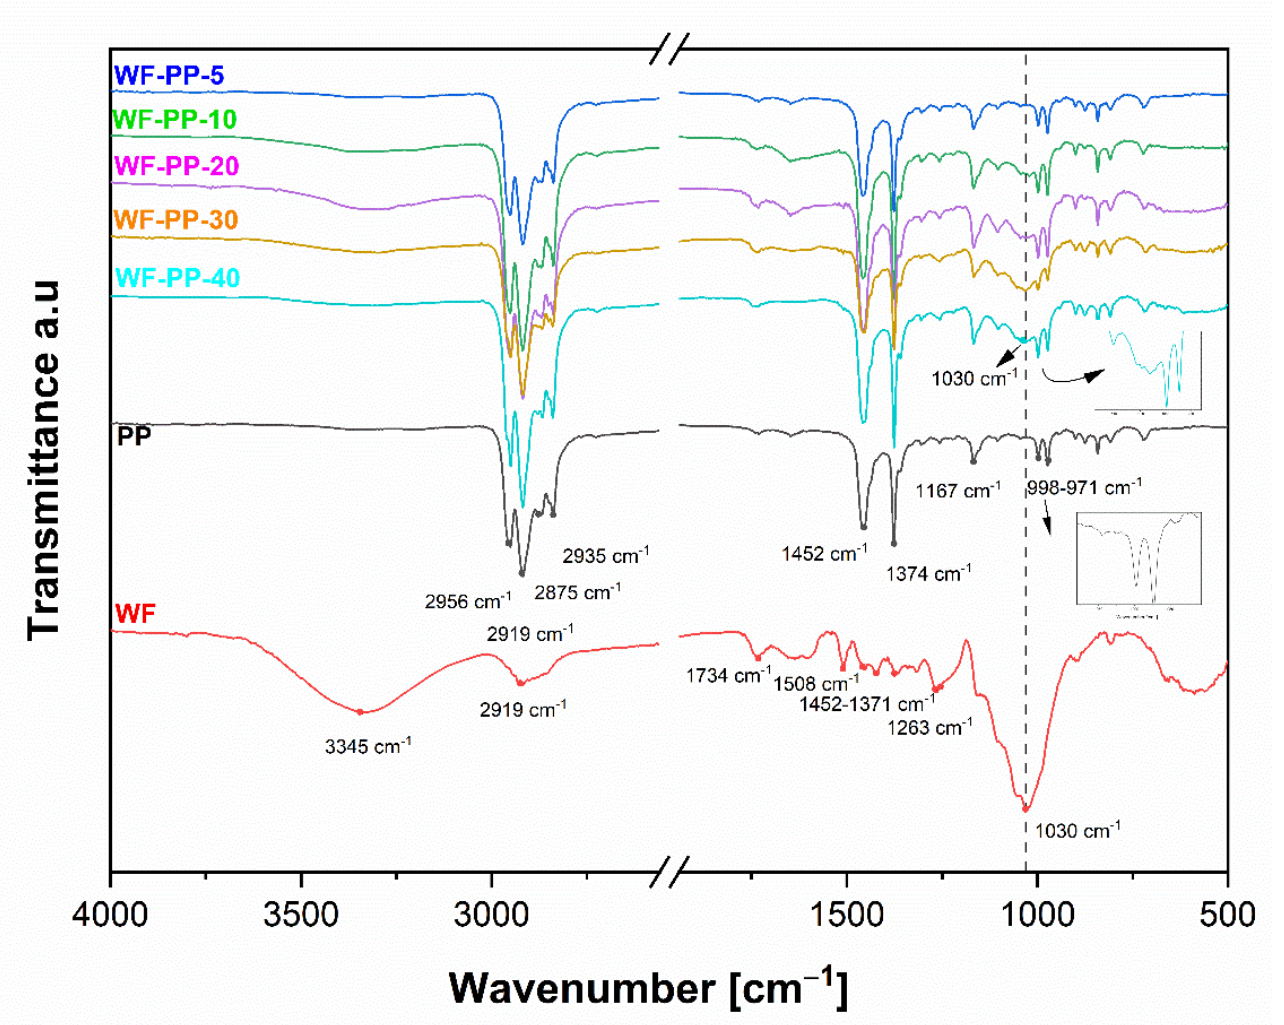
Figure 5. ATR-FTIR spectra of unrecycled PP, WF and wood fiber-polypropylene composites (WF-PP) injected moulded samples with different addition of WF content (from 5%:WF-PP-5 to 40%:WF-PP-40).